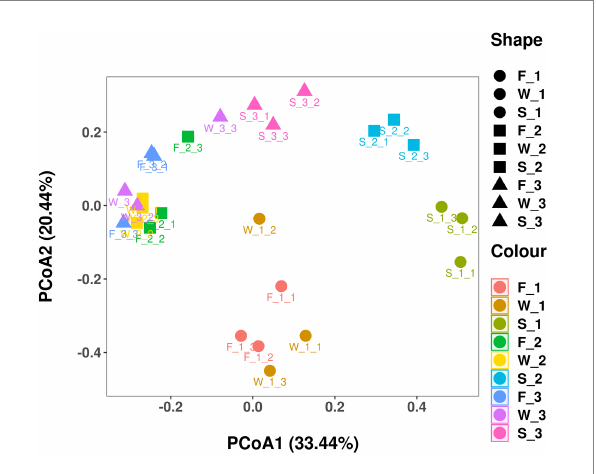
FIGURE 3 Unweighted unifrac principal coordinate analysis (PCoA) plot of individual samples in fresh alfalfa (F), wilted alfalfa (W), and ensiled alfalfa (S) at three cuttings. The PCoA plot indicates the phylogenetic distance (variation) between samples using 2 principal coordinates (PC1 and PC2). The percentage variation explained by each PC is indicated on each